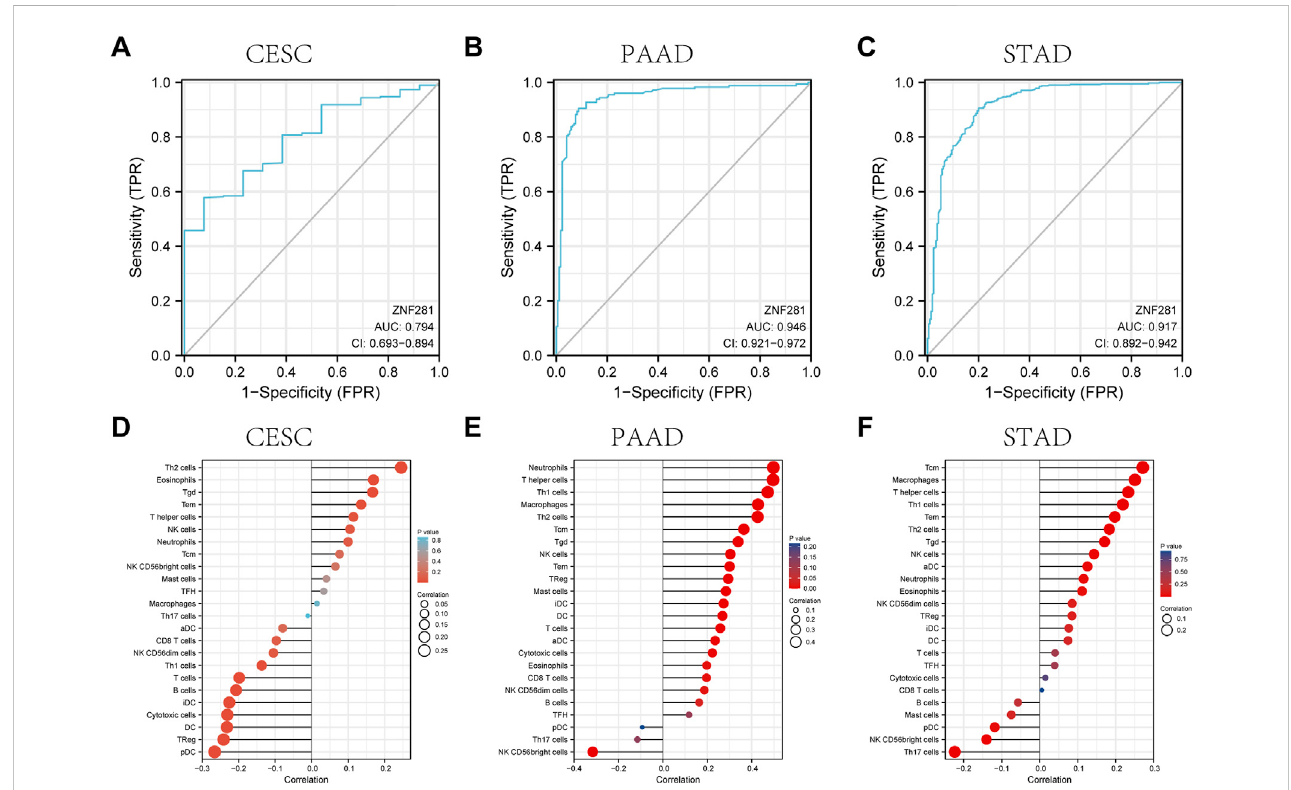
FIGURE 4 ROC curveand therelationshipwith immune cell in fi ltration for ZNF281 inCESC, PAAD, andSTAD. (A) ROC curvefor ZNF281 in CESC, (B) ROC curvefor ZNF281 in PAAD, and (C) ROC curve for ZNF281 in STAD. (D) Immune in fi ltration analysis for ZNF281 in CESC, (E) immune in fi ltration analysis for ZNF281 in PAAD, and (F) immune in fi ltration analysis for ZNF281 in